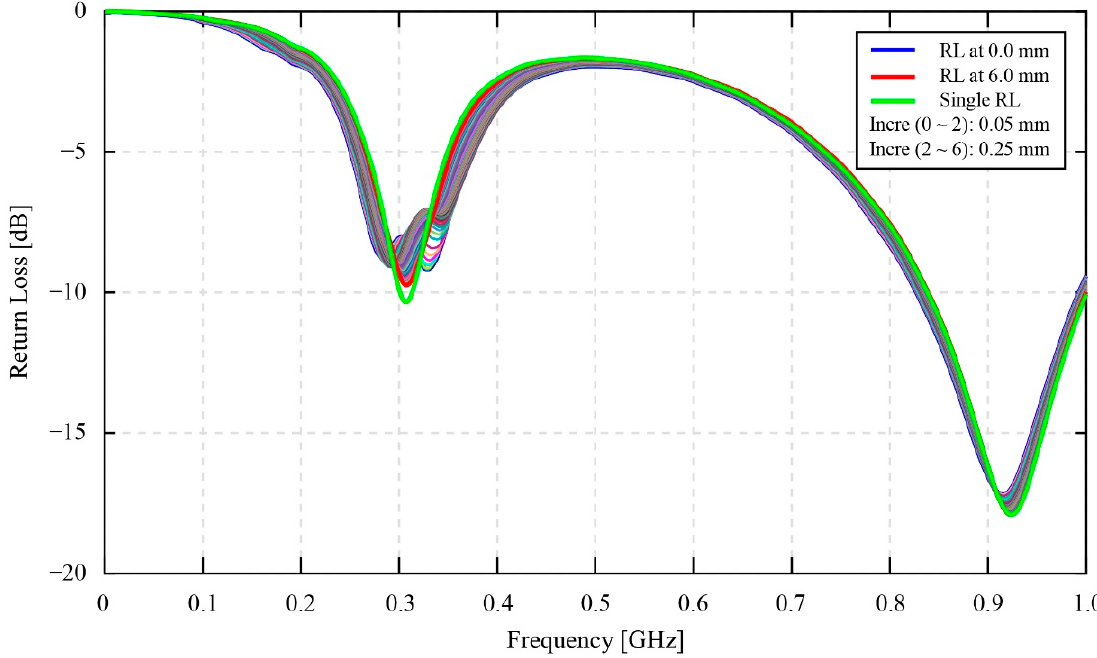
Figure 10. The effect of the coupling distance on the resonant signals of the smart gear system.